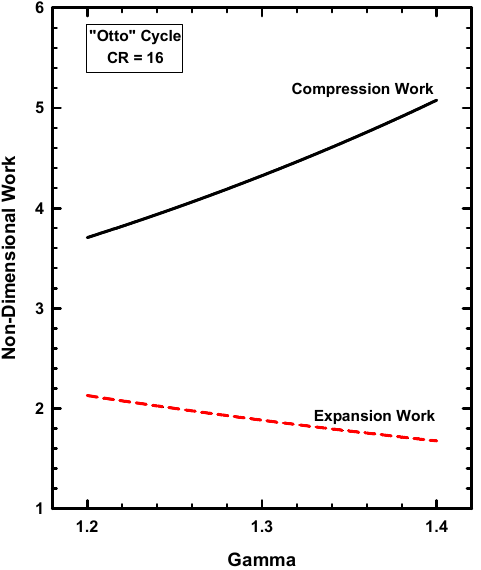
Figure 26. The non-dimensional work for the compression and expansion strokes as functions of gamma for a compression ratio of 16 for the Otto cycle.